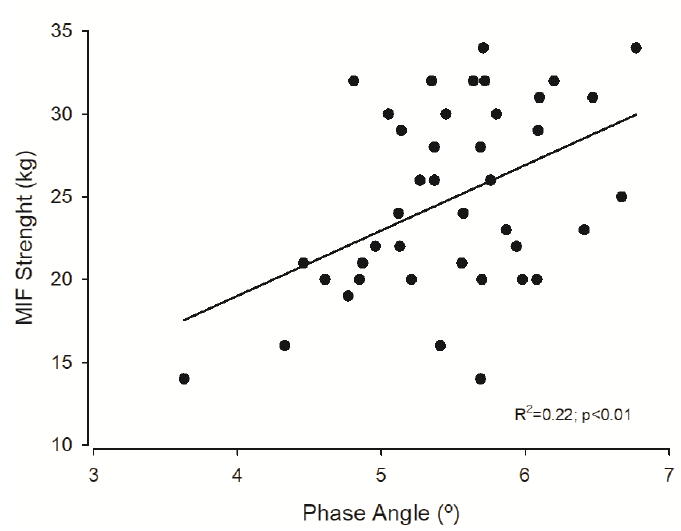
Figure 1 represents the association between forearm muscular strength and PhA.